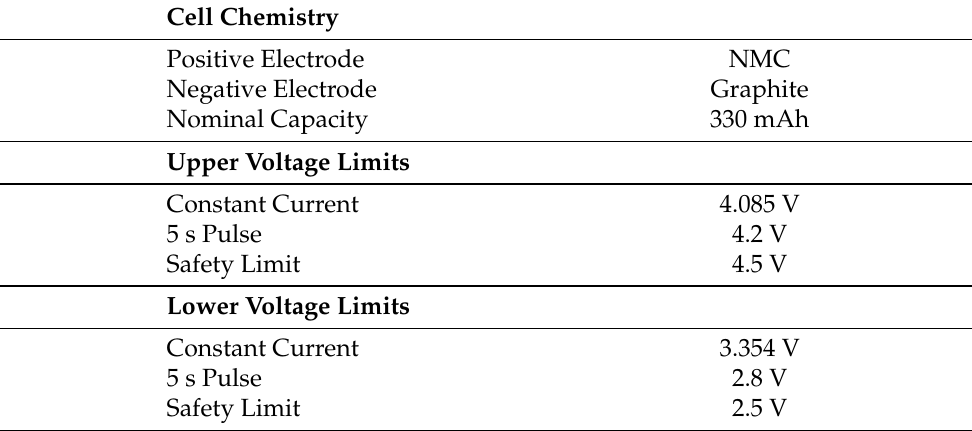
Table 1. Additional information on the lithium-ion